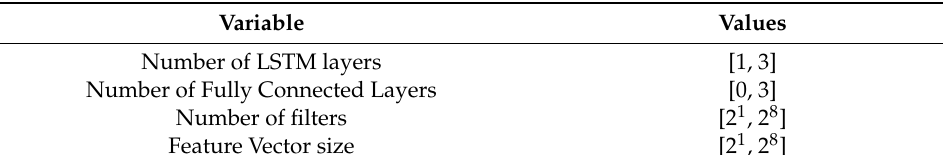
Table 6. LSTM hyperparameter random grid.